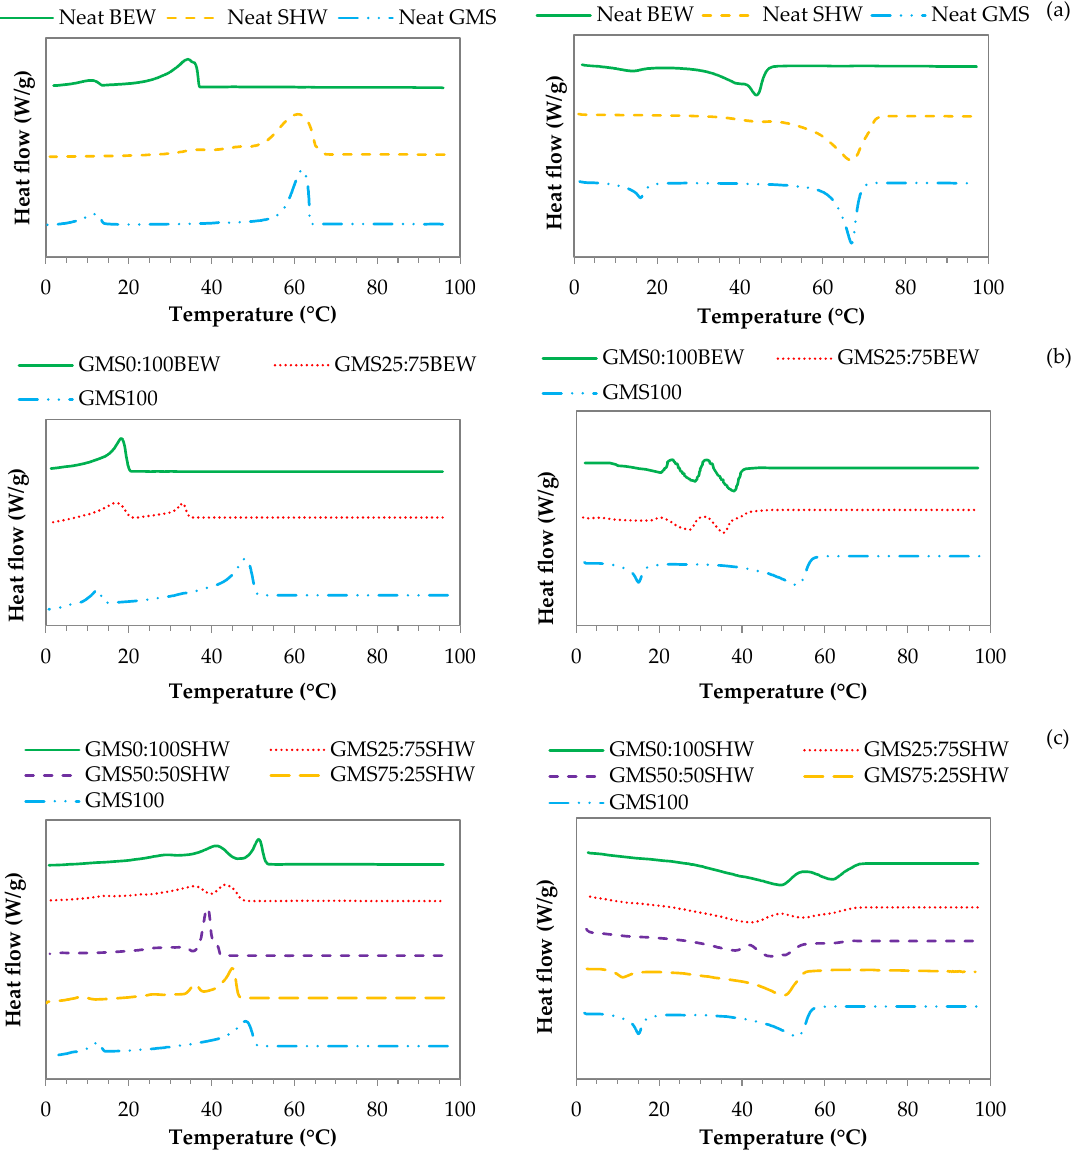
Figure 2. Crystallization (left) and melting (right) for neat BEW, SHW, and GMS ( a ) GMS:BEW-based oleogels ( b ) and GMS:SHW-based oleogels ( c ).